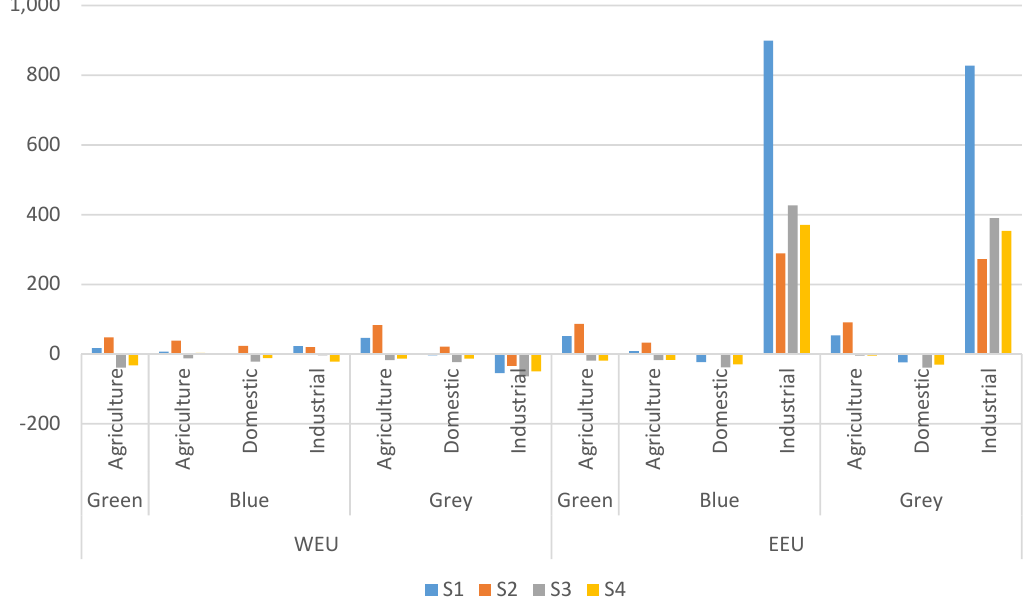
Figure 1. Percentage change in the WF of total production in WEU and EEU relative to 2000.